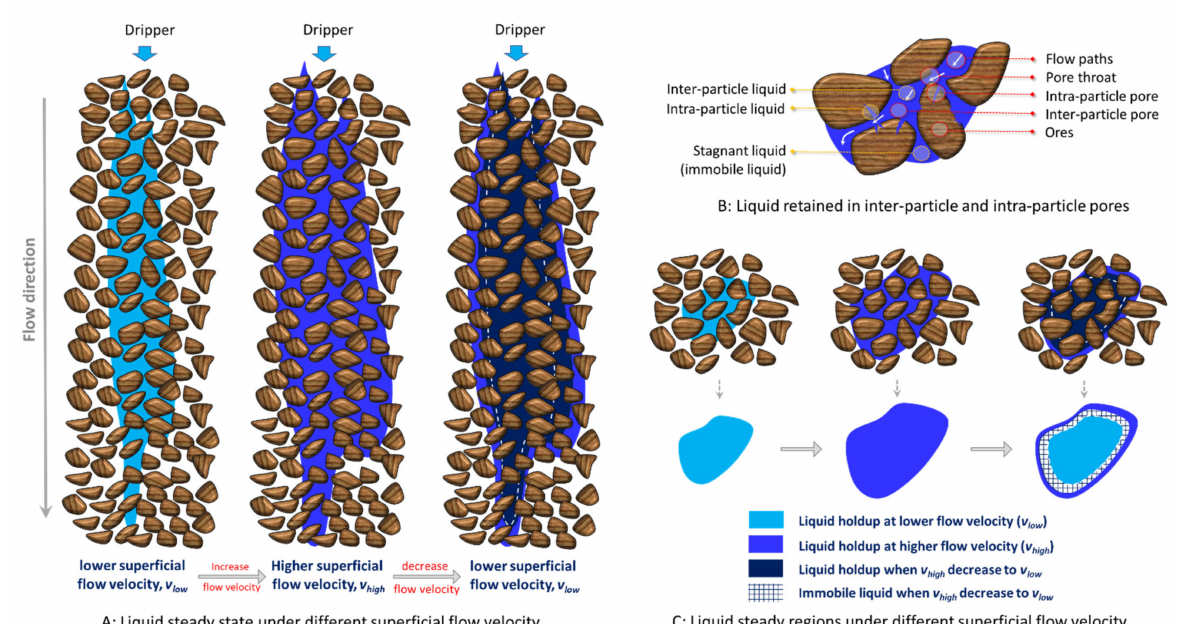
Figure 5. Schematic diagram of liquid holdup and hysteresis behavior in unsaturated packed bed. ( A ): liquid steady state under different superficial flow rate, ( B ): liquid retained in inter-particle and intra-particle pores, ( C ): liquid steady region under different superficial flow rate.